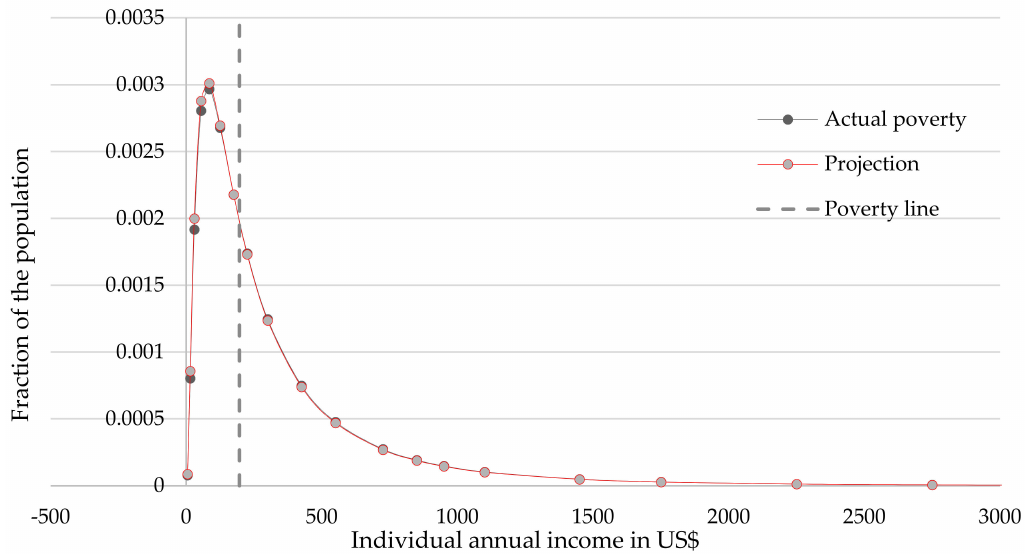
Figure 10. Annual per-capita income (US$) distribution of Bangladesh (17% loss of rice).